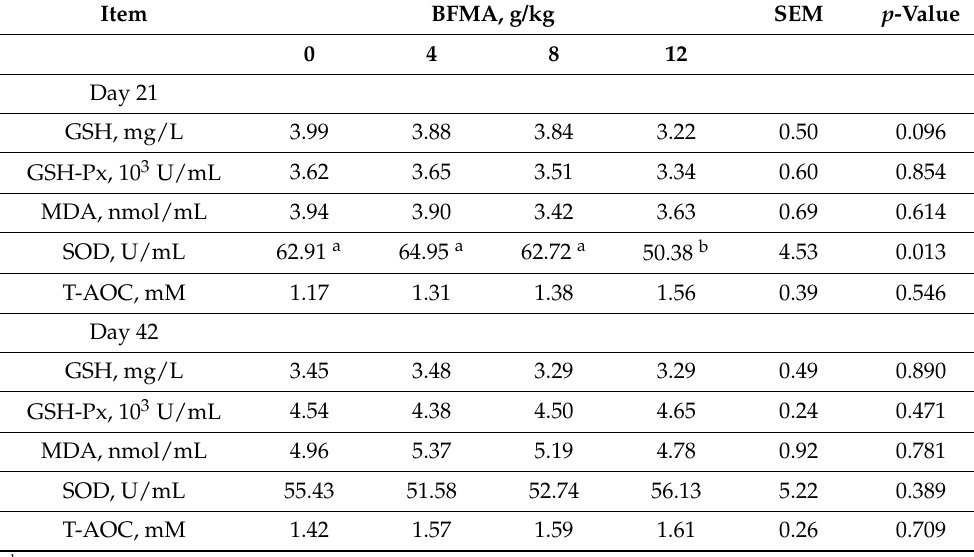
Table 4. Effects of dietary malic acid on serum antioxidant capacity of